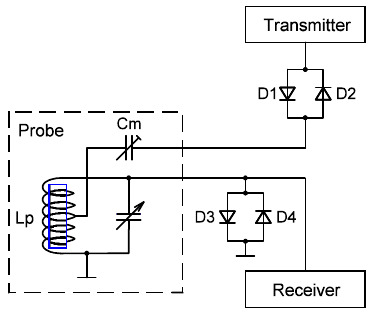
Figure 2. Basic structure of the NQR sensor.